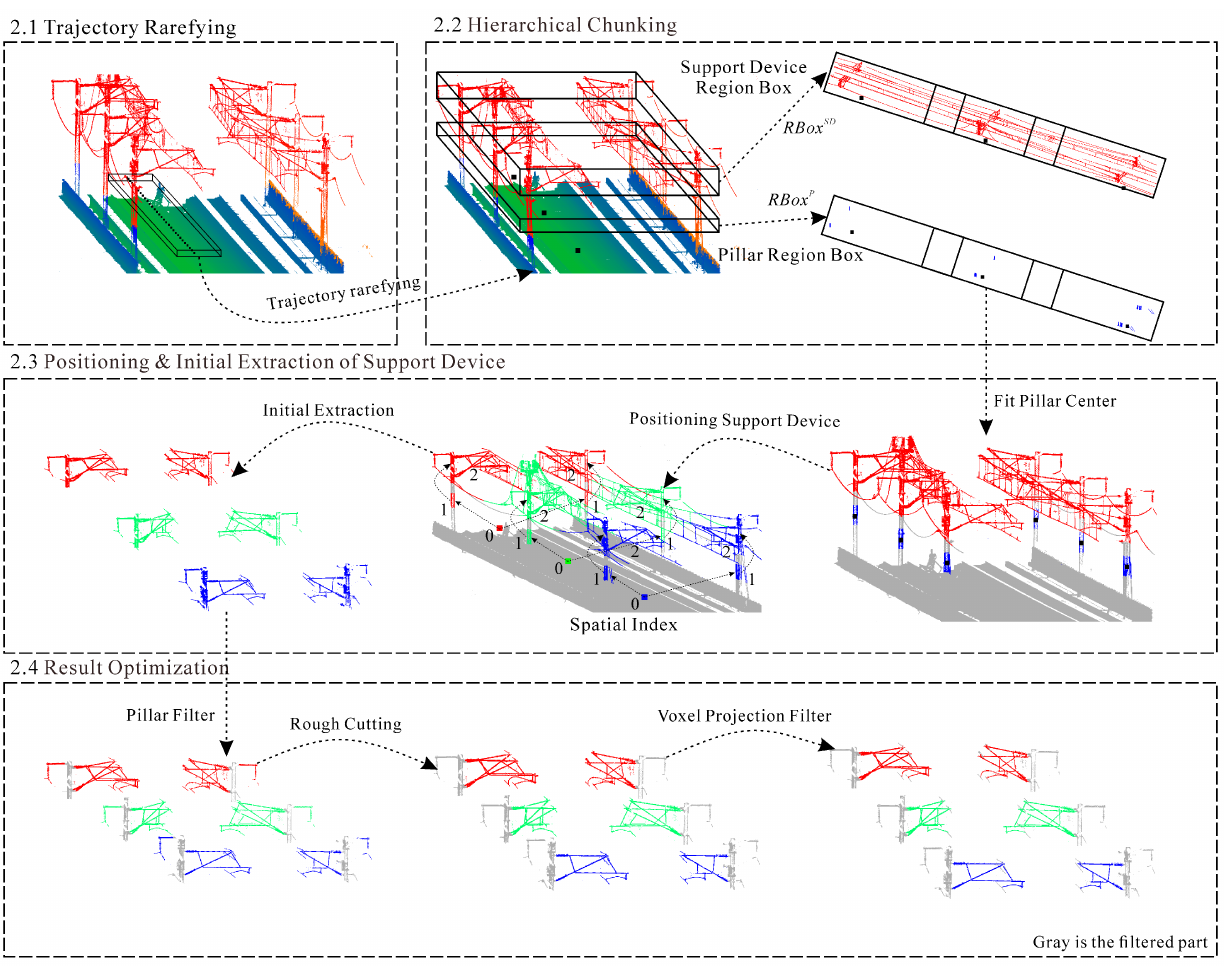
Figure 2. The overall flowchart of the